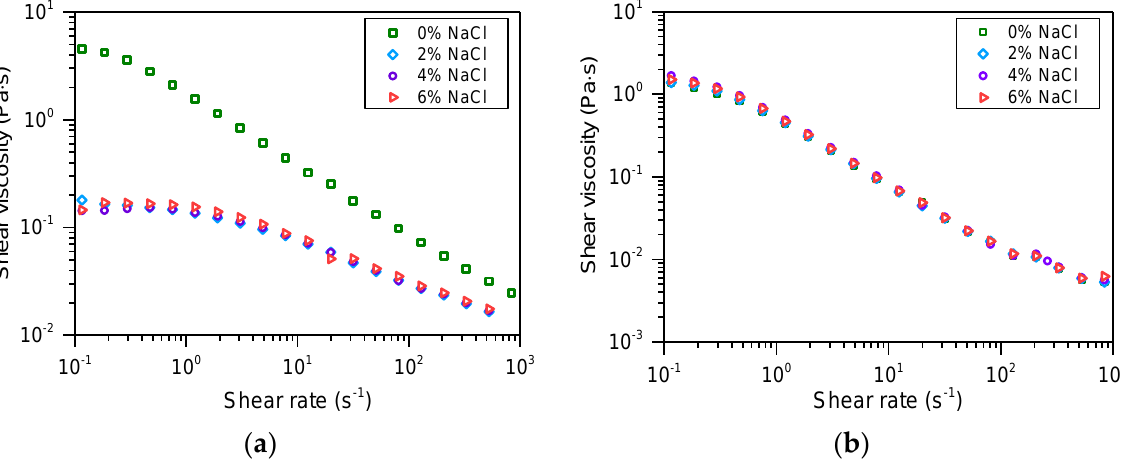
Figure 6. Shear viscosity of ( a ) HPAM and ( b ) biopolymer solution at various NaCl content.